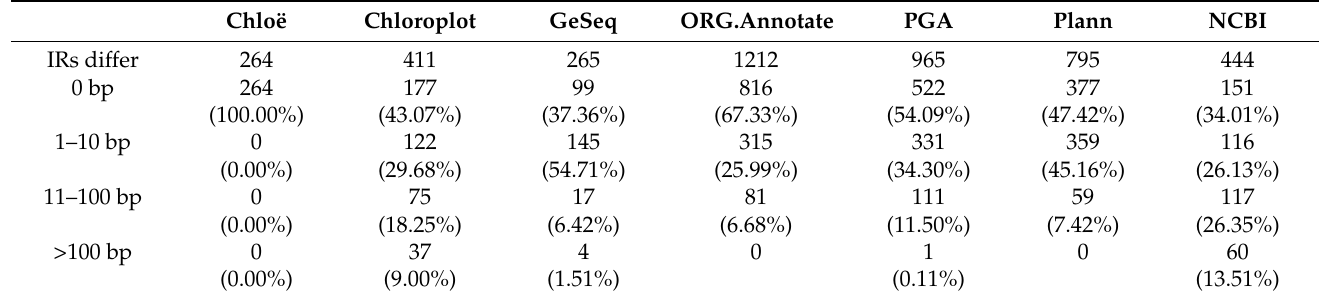
Table 6. Number of sequences with different IRs identified with six annotation tools (and those annotated in NCBI), classified by the length difference between IRa and IRb.